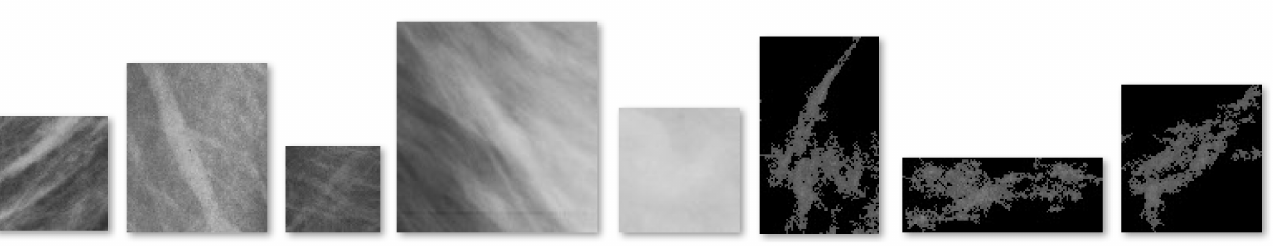
Figure 1. Normal tissues of the mammary